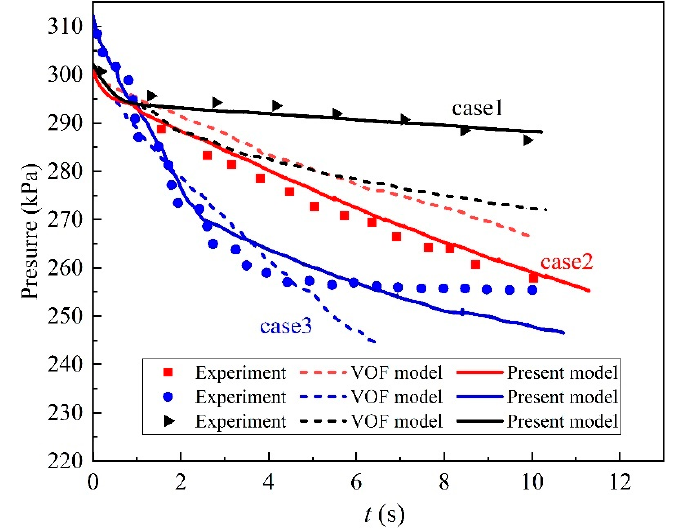
Figure 4. Comparison of tank pressure (CFD simulation and experimental results) [20]. (Case 1: f = 0.29, θ A = 3 ◦ ; Case 2: f = 0.40, θ A = 3 ◦ ; Case 3: f = 0.57, θ A = 3 ◦ ).